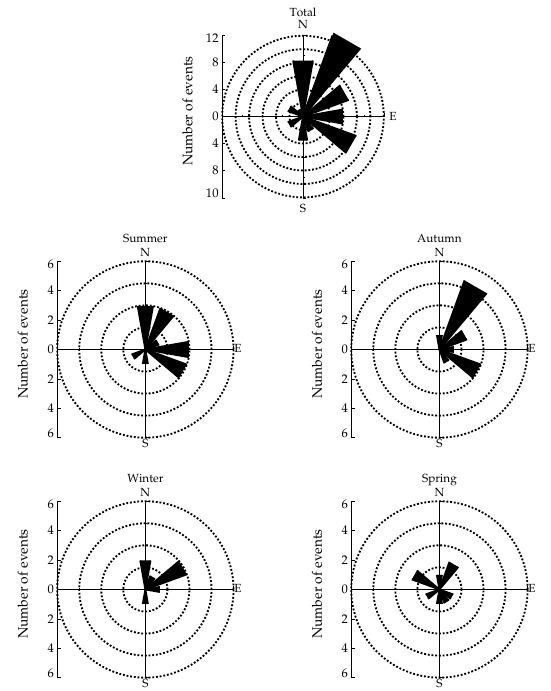
Figure 10. Overall and seasonal distributions of MSGW propaga- tion direction for